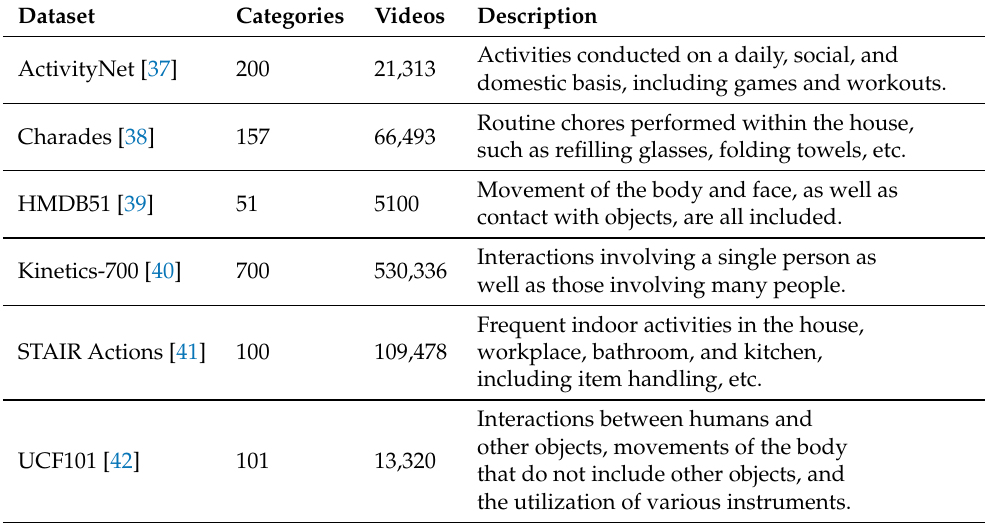
Table 1. Human activity recognition (HAR) dataset